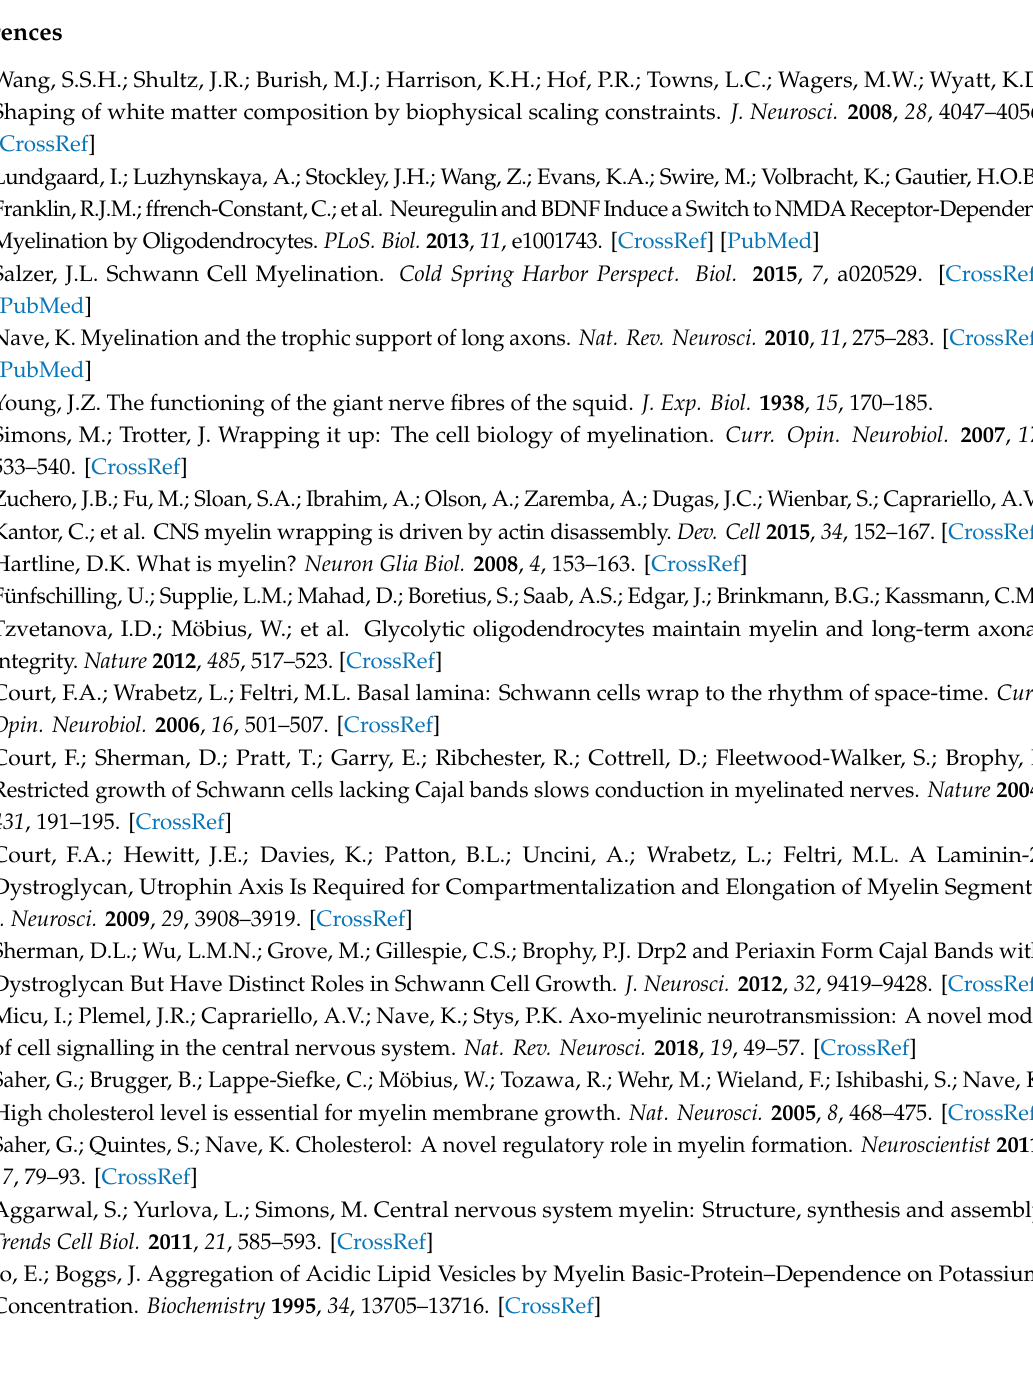
Table S1: Sequence analysis of all human L-PRX regions (UniProtKB - Q9BXM0-1) using